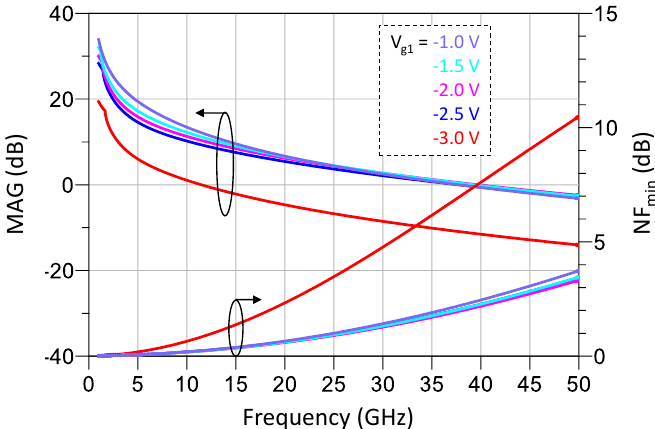
Figure 5. Reverse isolation and stability characteristic of the proposed